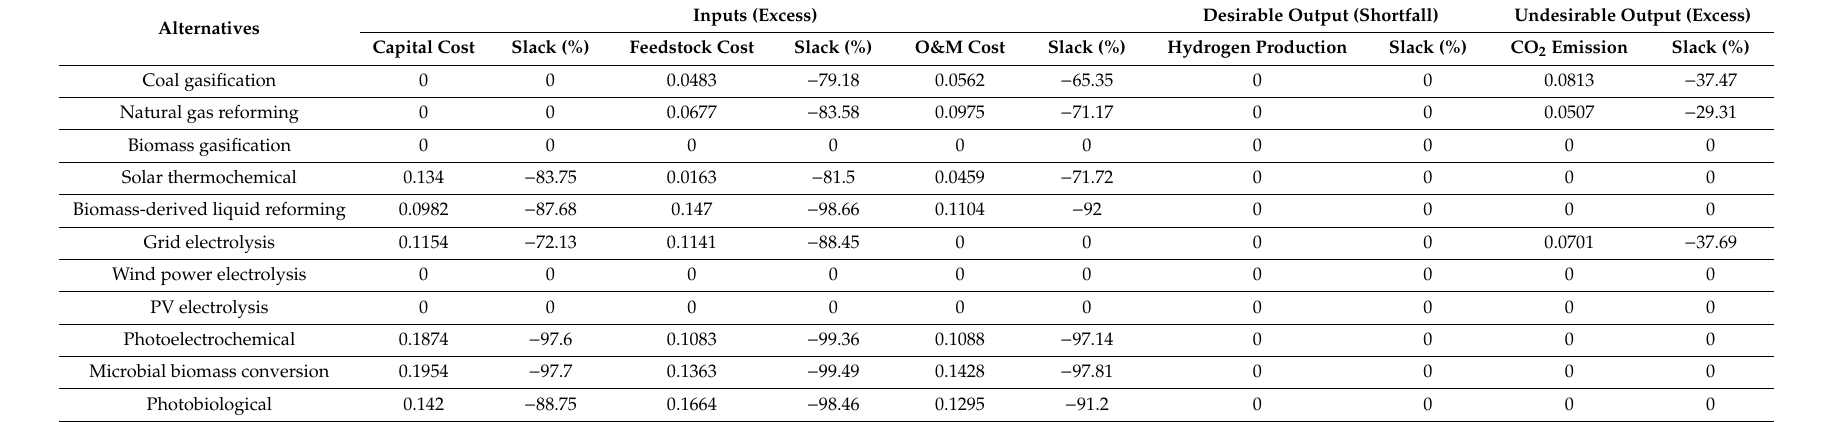
Table 11. Slacks of inputs, desirable outputs, and undesirable